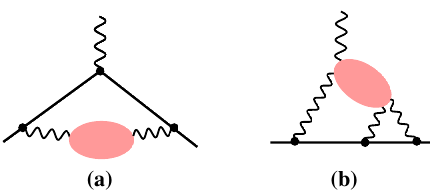
Figure 1. Hadronic contributions to ( g (cid:0) 2) (cid:22) : (a) HVP, (b) HLbL. The pink blobs symbolize hadronic intermediate states.